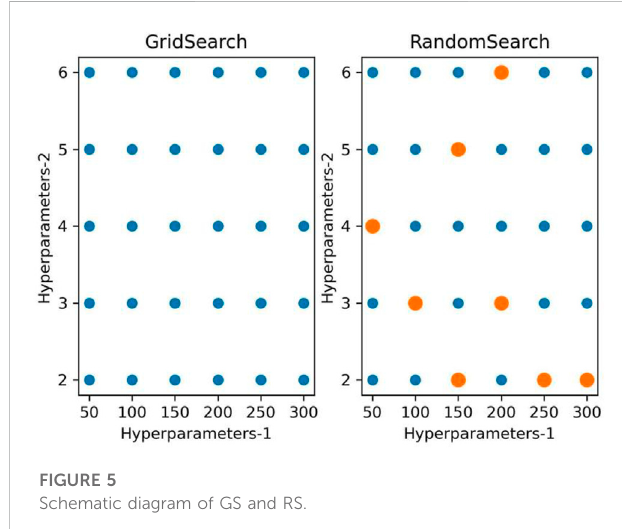
FIGURE 5 Schematic diagram of GS and RS.